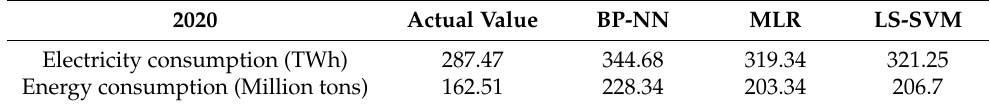
Table 3. Predictive values in